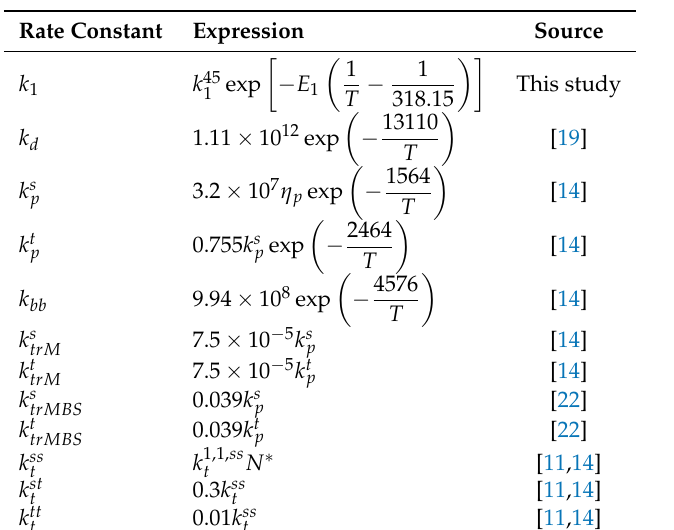
Table 4. Chemical reaction rate constants and sources. Temperature in [K], first-order constants